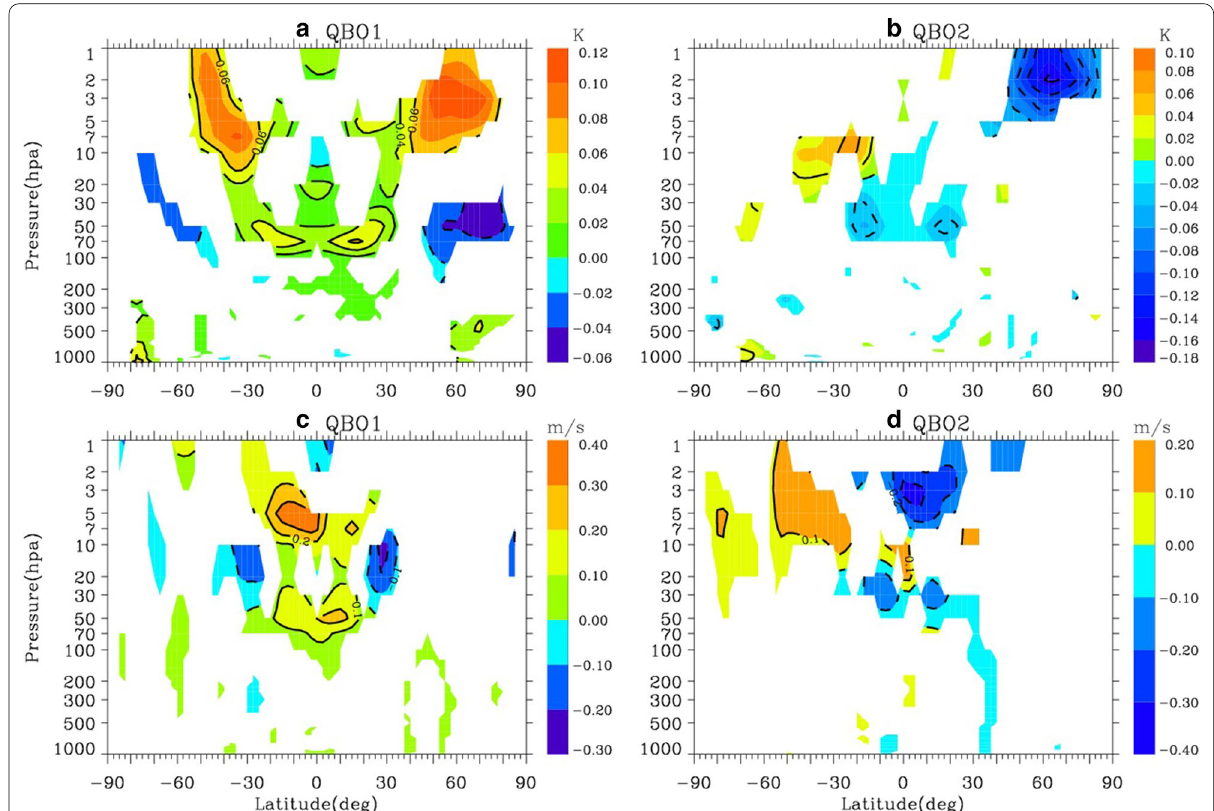
Fig. 6 Latitude-pressure sections of the responses of the monthly-mean Q16W1 temperature amplitude to ( a ) QBO1 and ( b ) QBO2. Similar to the temperature amplitude, ( c ) and ( d ) correspond to the responses of the zonal wind amplitude to QBO1 and QBO2, respectively. Only the results with a confidence level at/above 95% are plotted as contours. The solid and dashed contours denote the positive and negative responses,